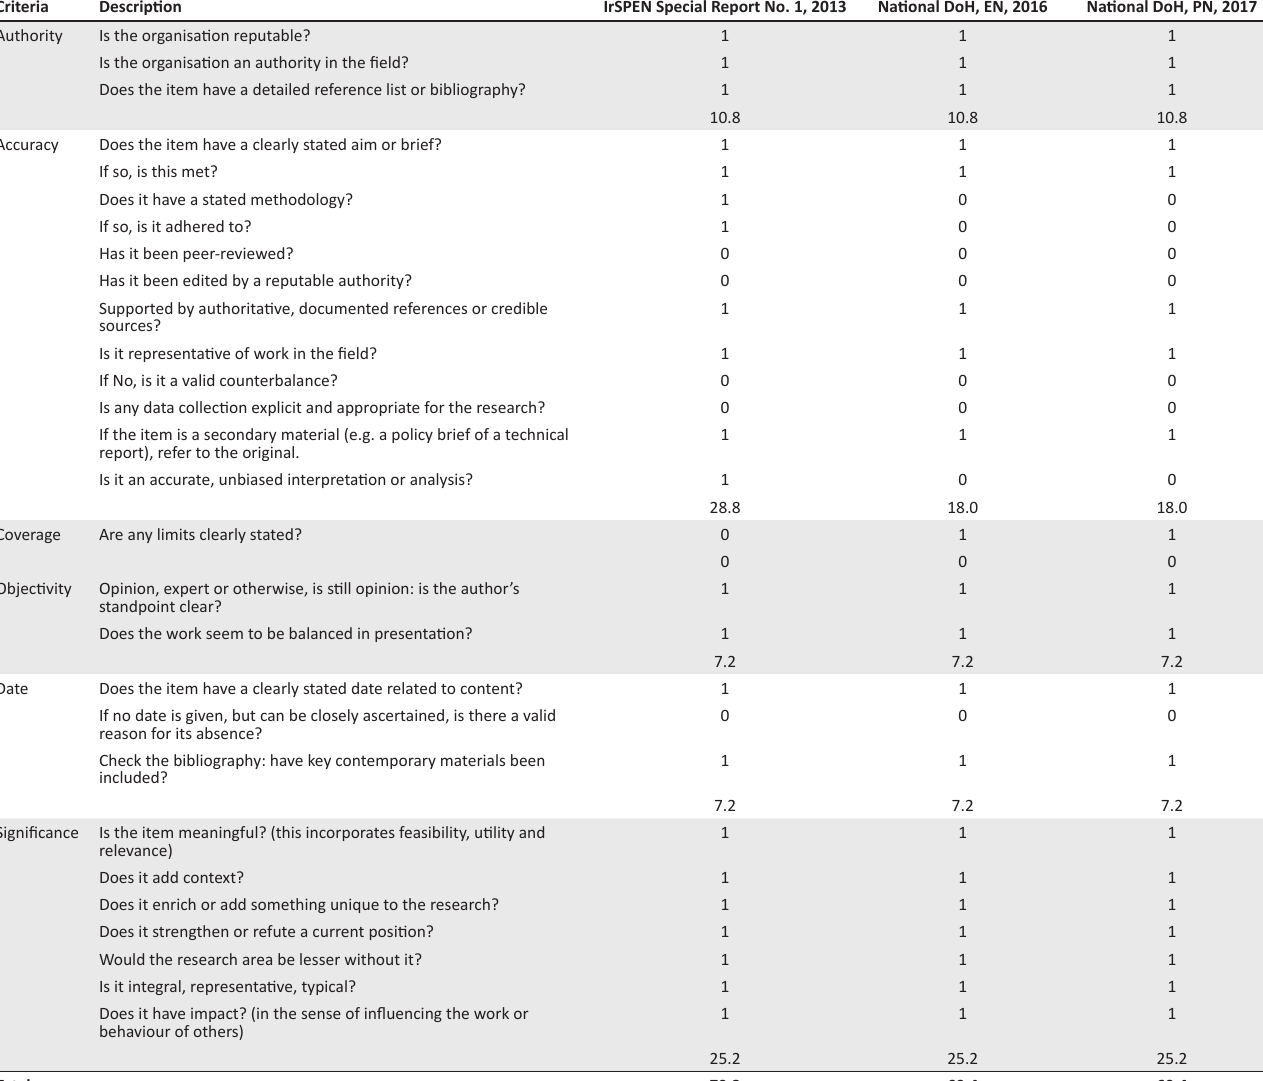
TABLE 5a: Summary of quality assessment report of included studies from grey literature (AACODS). Criteria